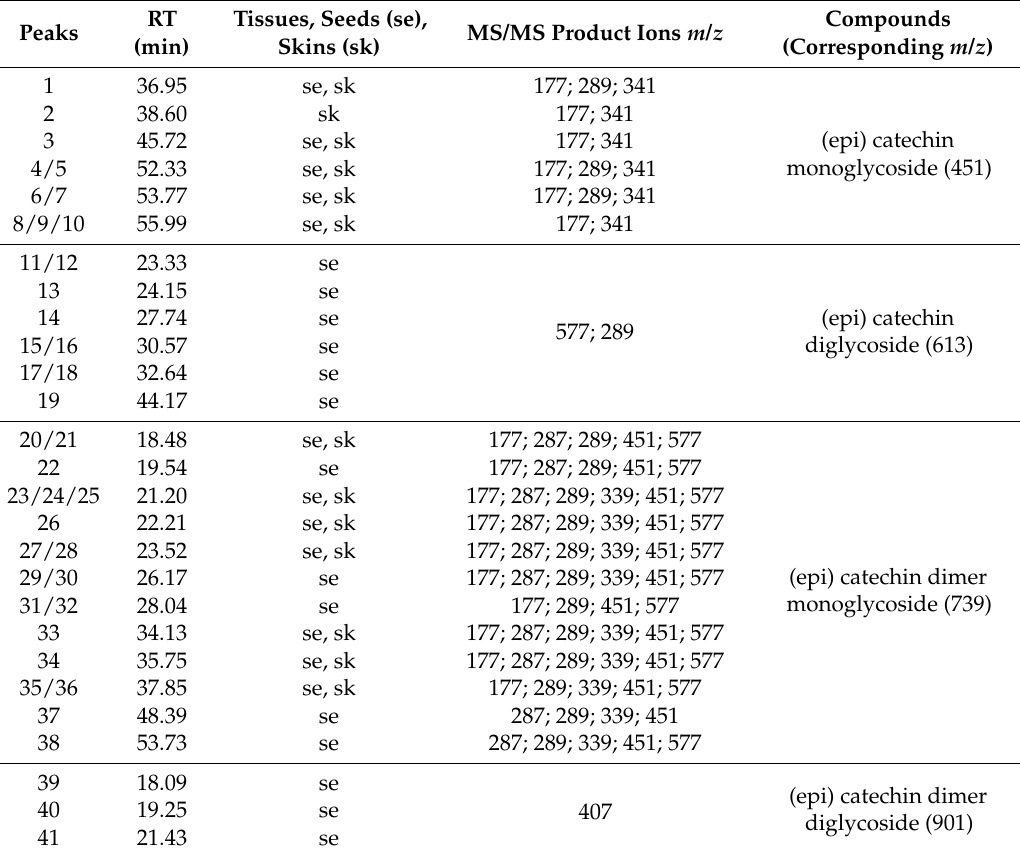
Table 1. (Epi) catechin glycosides isomer peaks with their related retention time and fragmentation pattern from MS/MS analysis.